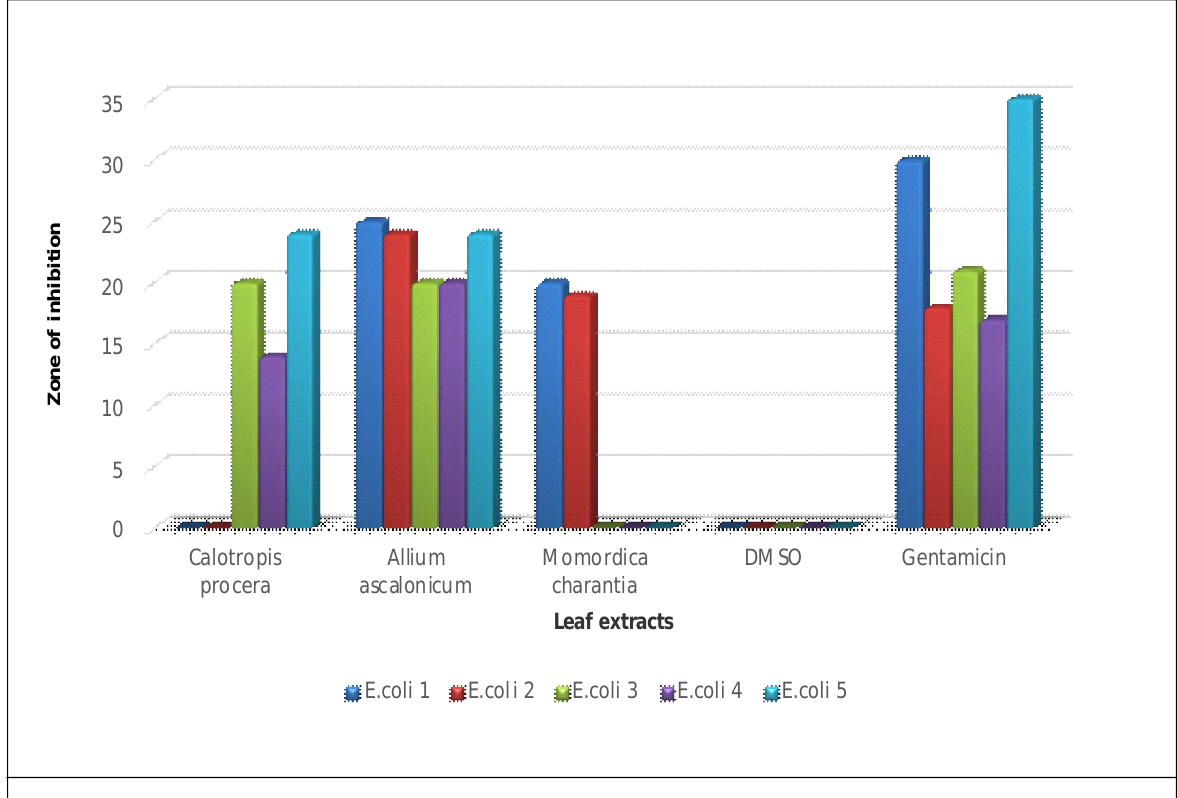
Figure 1: Antimicrobial activity of the